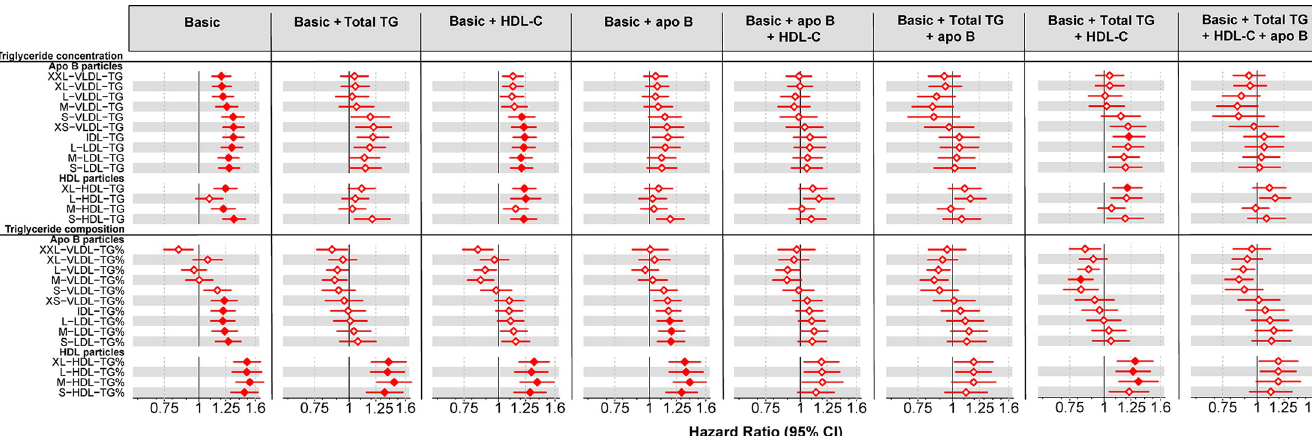
PLOS Biology | https://doi.org/10.1371/journal.pbio.3000572 December 20,